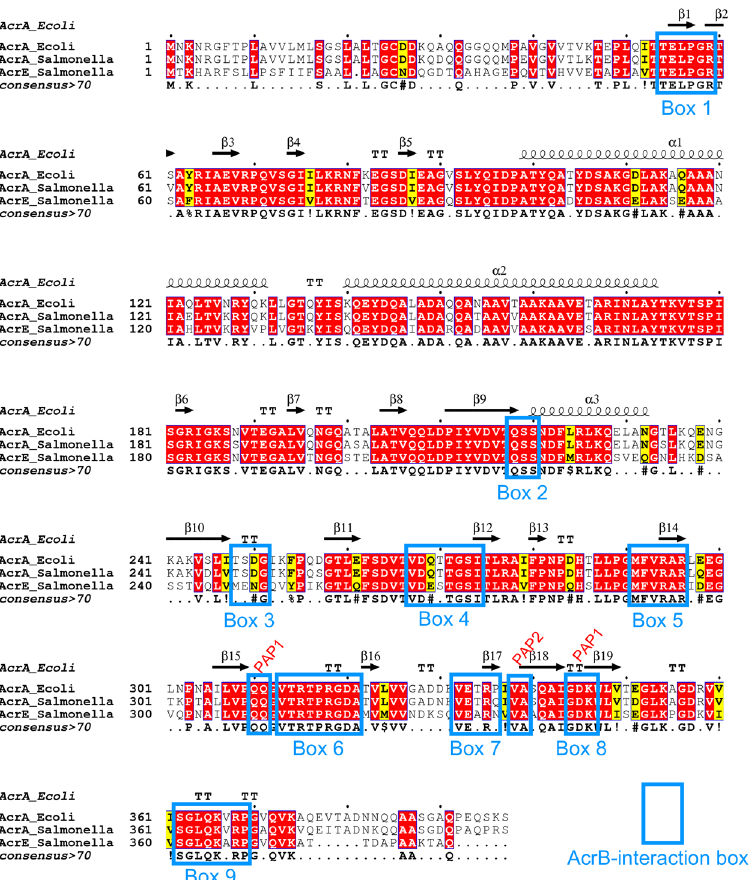
Figure 1. Multiple sequence alignment of Salmonella AcrA and AcrE combined with the mapping of the secondary structure derived from the experimentally defined structure of E. coli AcrA (PDB 5V5S, chain G) 20 . Identical residues are coloured red and similar residues are coloured yellow. The PAP-binding boxes implicated in RND-binding 22 are numbered 1 to 9 and depicted using blue rectangles. Figure created using Espript 3.0 47